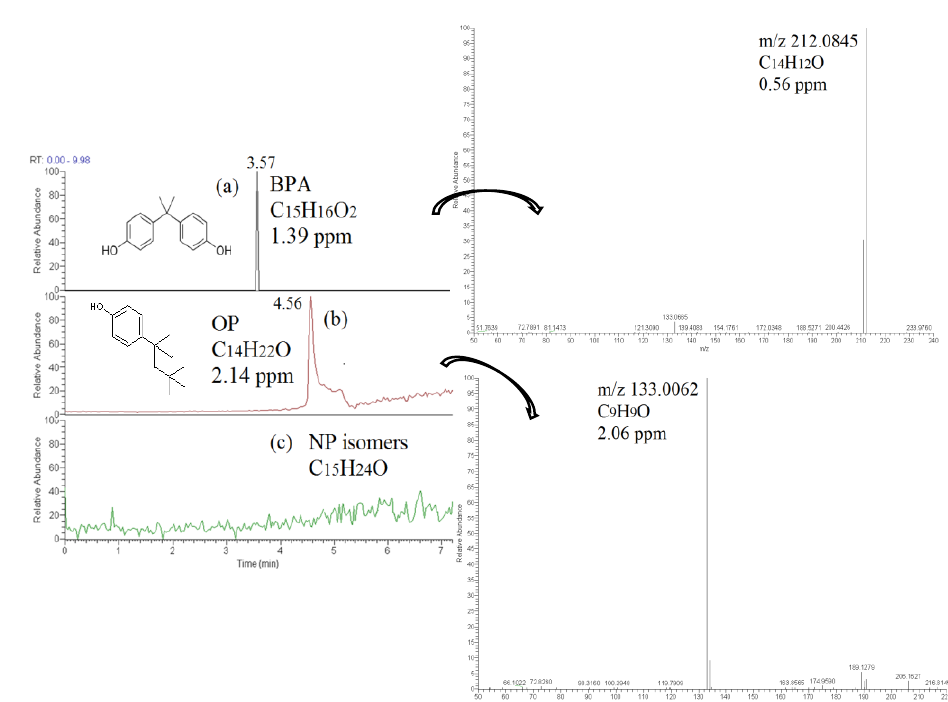
Figure 4. LC-LTQ/Orbitrap MS Extracted Ion Chromatogram (EIC) of a strained yogurt sample where BPA and OP were detected at the concentration of 9.1 and 215.4 ng g − 1 , respectively: ( a ) BPA; ( b ) OP; ( c ) nonylphenol isomers (NP, 4NP) were not detected.